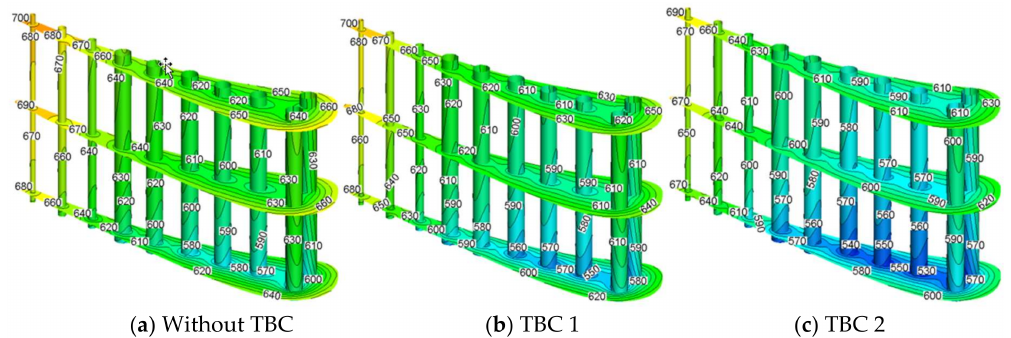
Figure 16. Contours of vane internal temperature of at Tu =